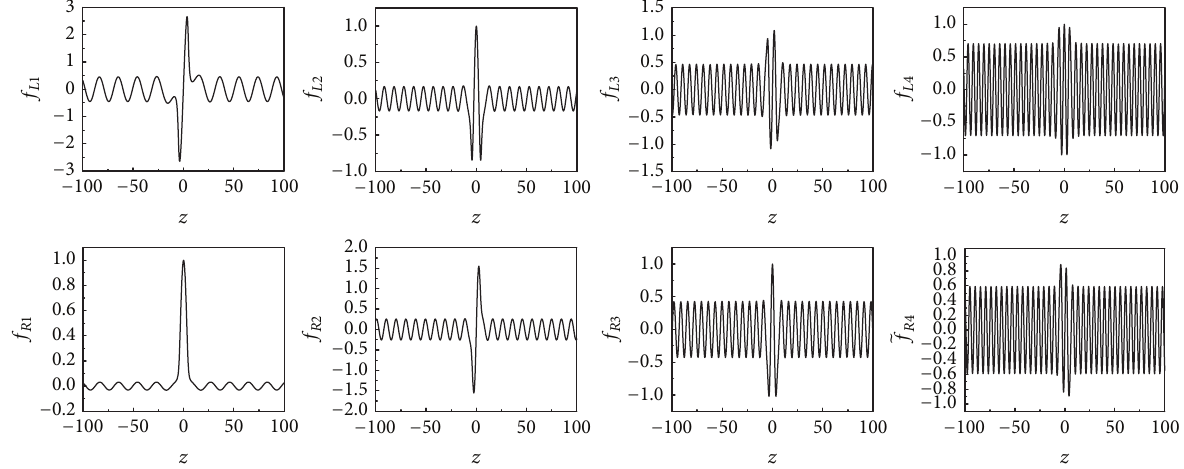
Figure 6: Plots of the left-handed and right-handed fermion resonances with 𝜂 = 1 , 𝜆 = 1 , and 𝑎 = 5